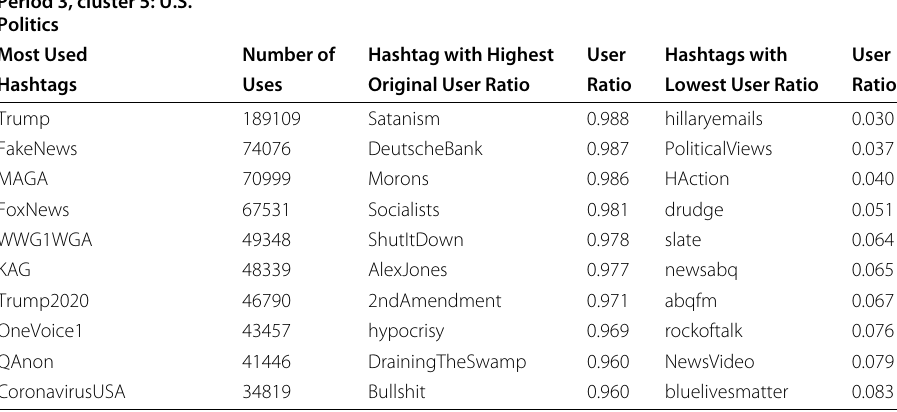
Table 7 Important hashtags from period 3 cluster 5 which has U.S. Politics related hashtags Period 3, cluster 5: U.S. Politics